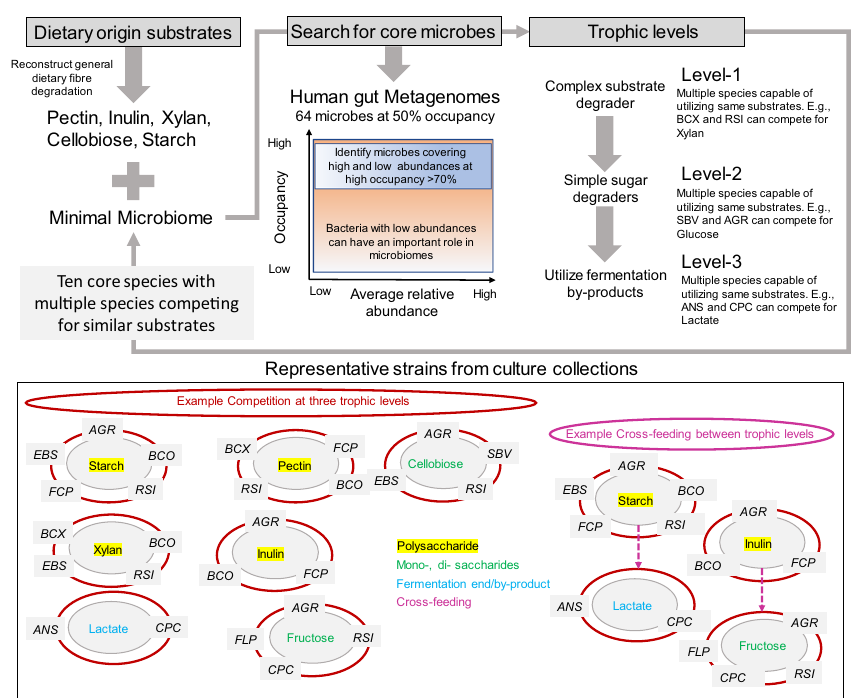
Fig. 1 Design of a diet-based minimal microbiome. We aimed to reconstruct the metabolic pathways and species interactions involved in degradation of dietary fi bres and production of short-chain fatty acids. Abbreviations: AGR A. rectalis , ANS A. soehngenii , BCO B. ovatus , BCX B. xylanisolvens , CPC C. catus , EBS E. siraeum , FCP F. prausnitzii , FLP F. plautii , RSI R. intestinalis , SBV S. variabile